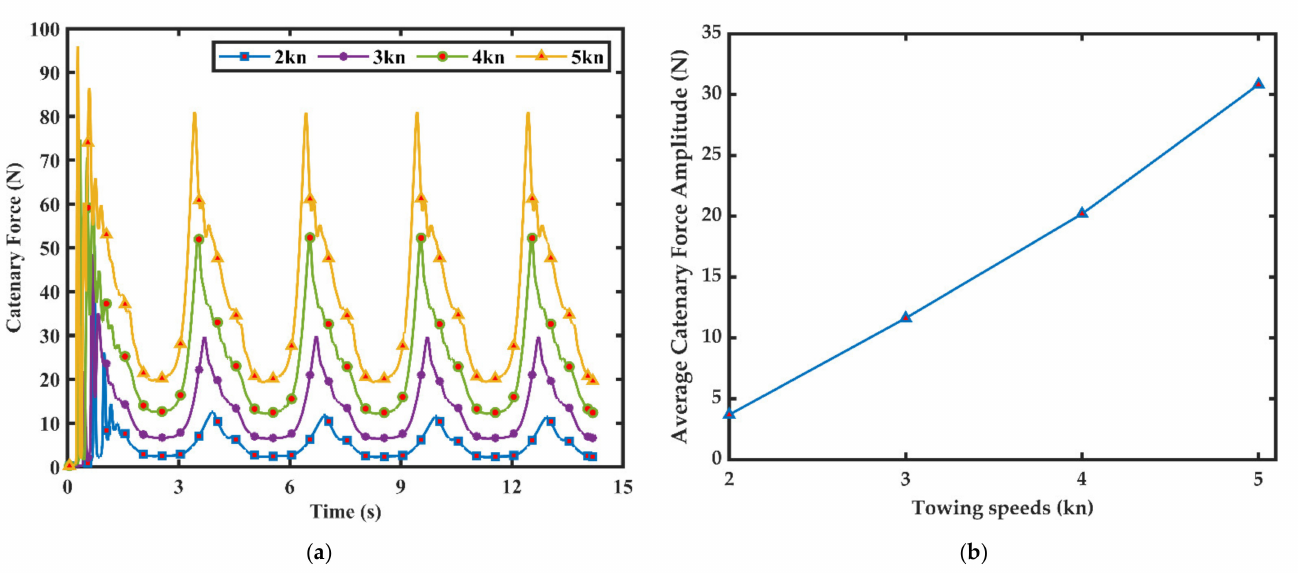
Figure 12. Time history of the of cable force at different towing speeds: ( a ) cable force; ( b ) average cable force